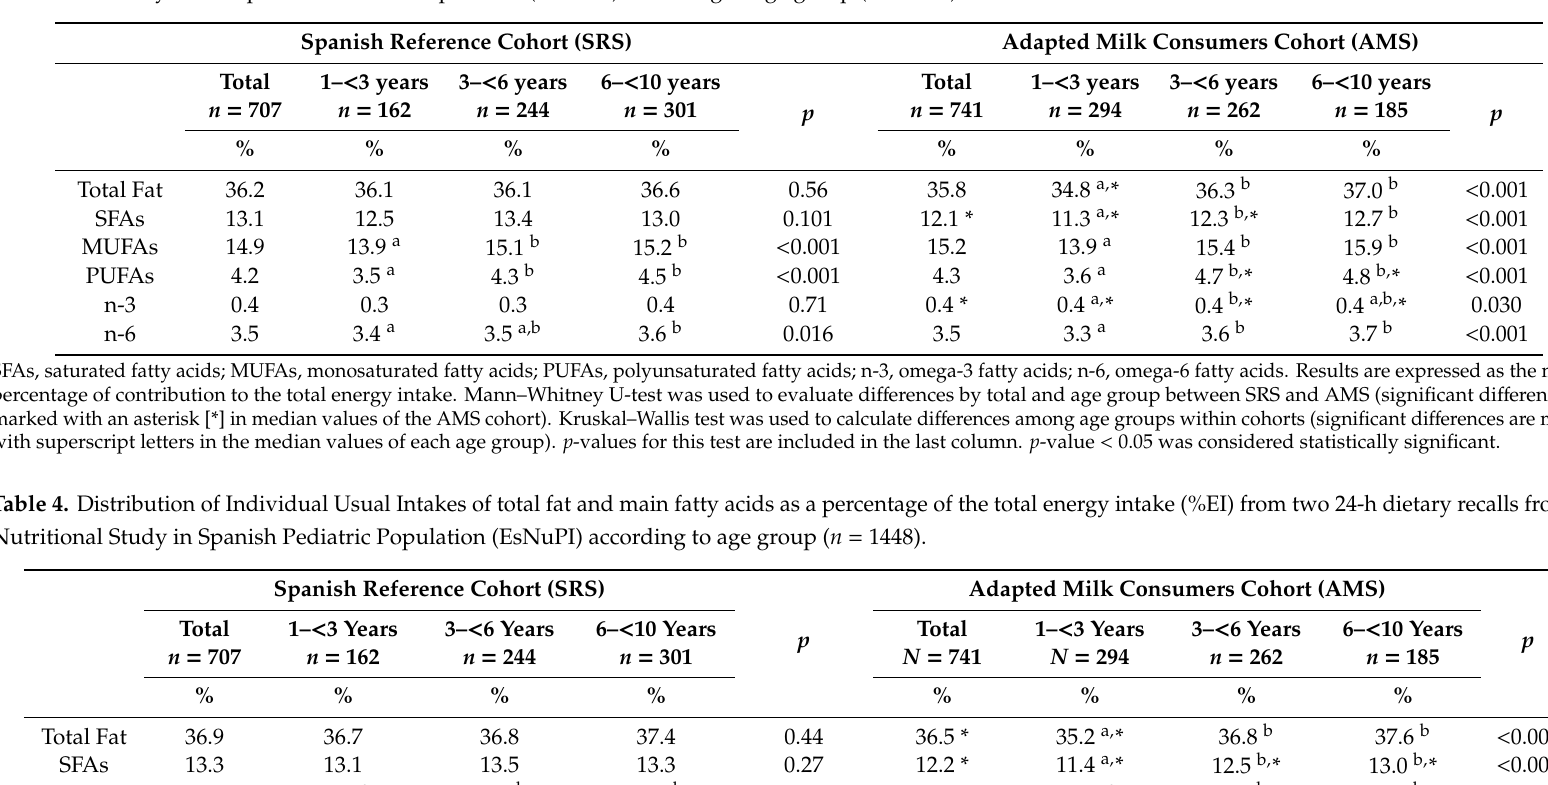
Table 3. Distribution of reported intakes of total fat and main fatty acids as a percentage of the total energy intake (%EI) from two 24-h dietary recalls from the Nutritional Study in the Spanish Pediatric Population (EsNuPI) according to age group ( n = 1448).